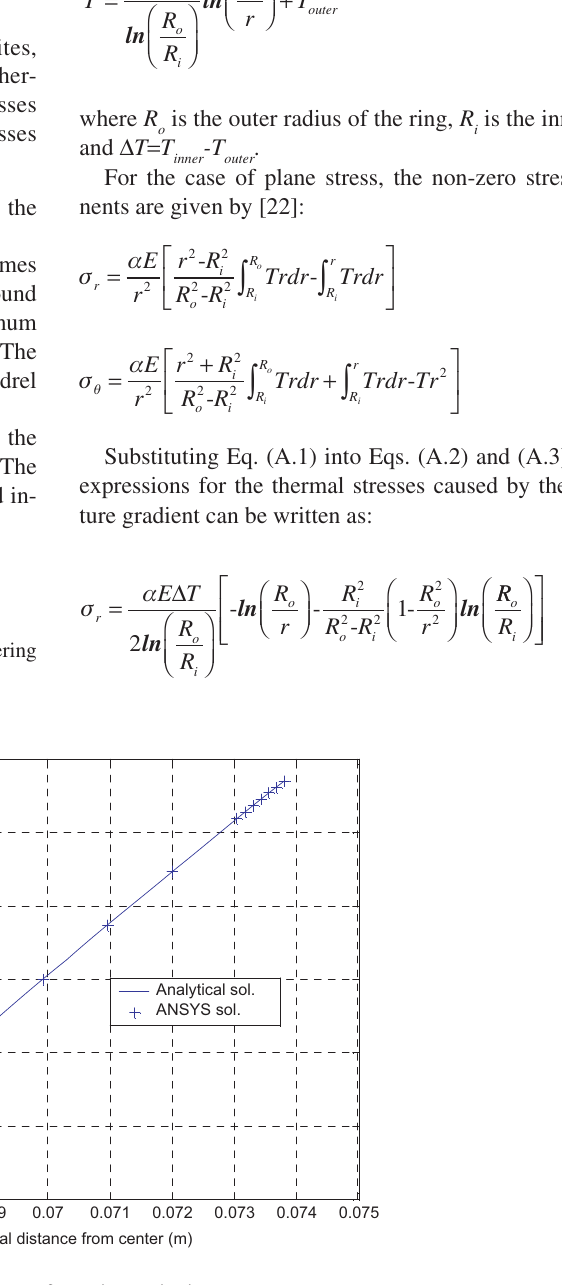
Figure 19 Temperature as a function of radial distance from center for an isotropic